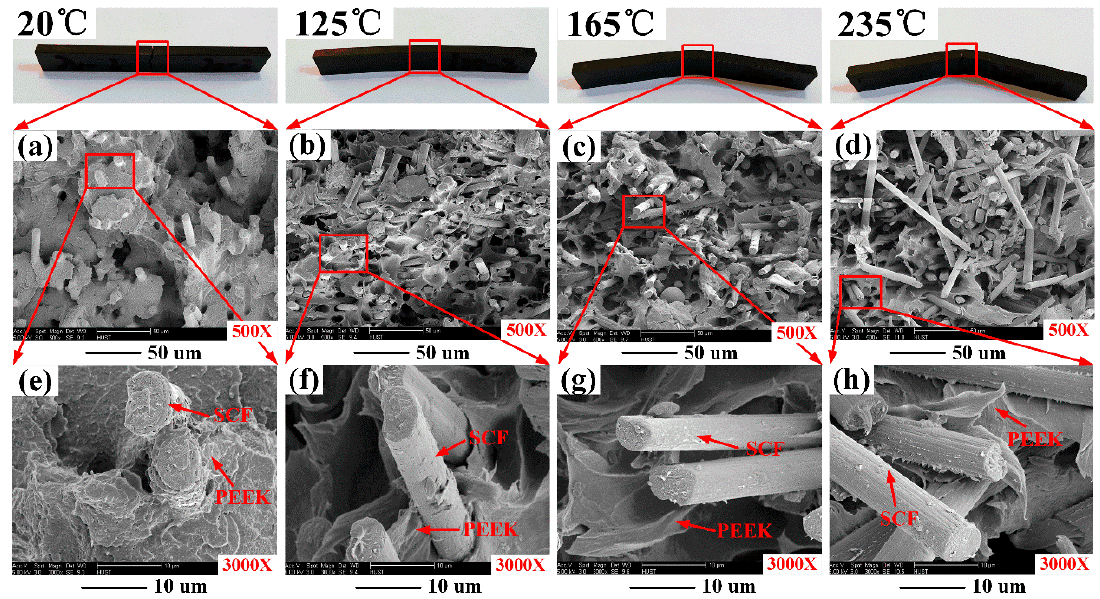
Figure 7. Scanning electron microscope (SEM) images of the fracture surfaces of SCFR/PEEK after flexural testing at various temperatures.